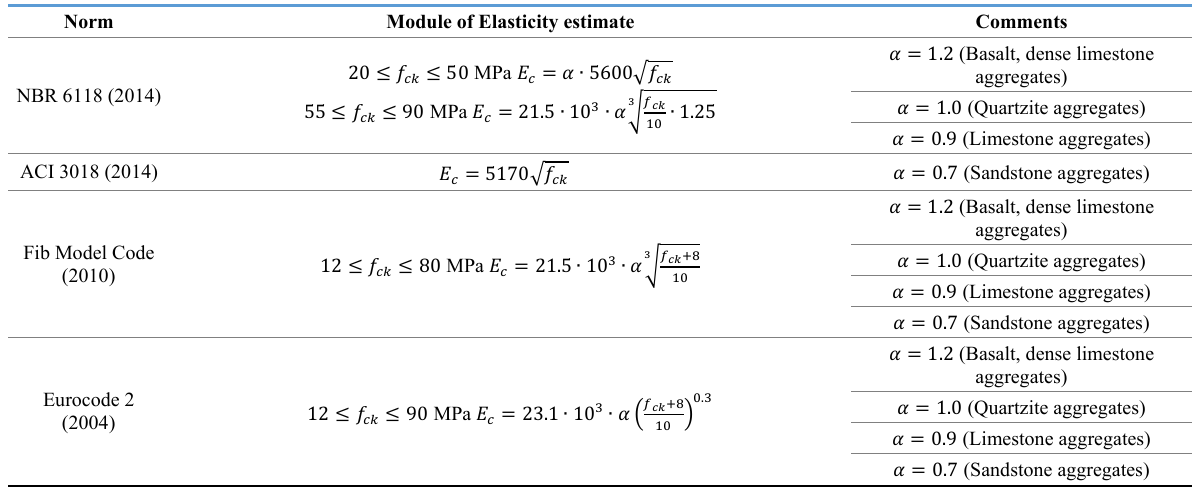
Table 3: Normative equations to estimate the modulus of elasticity of concrete. Norm